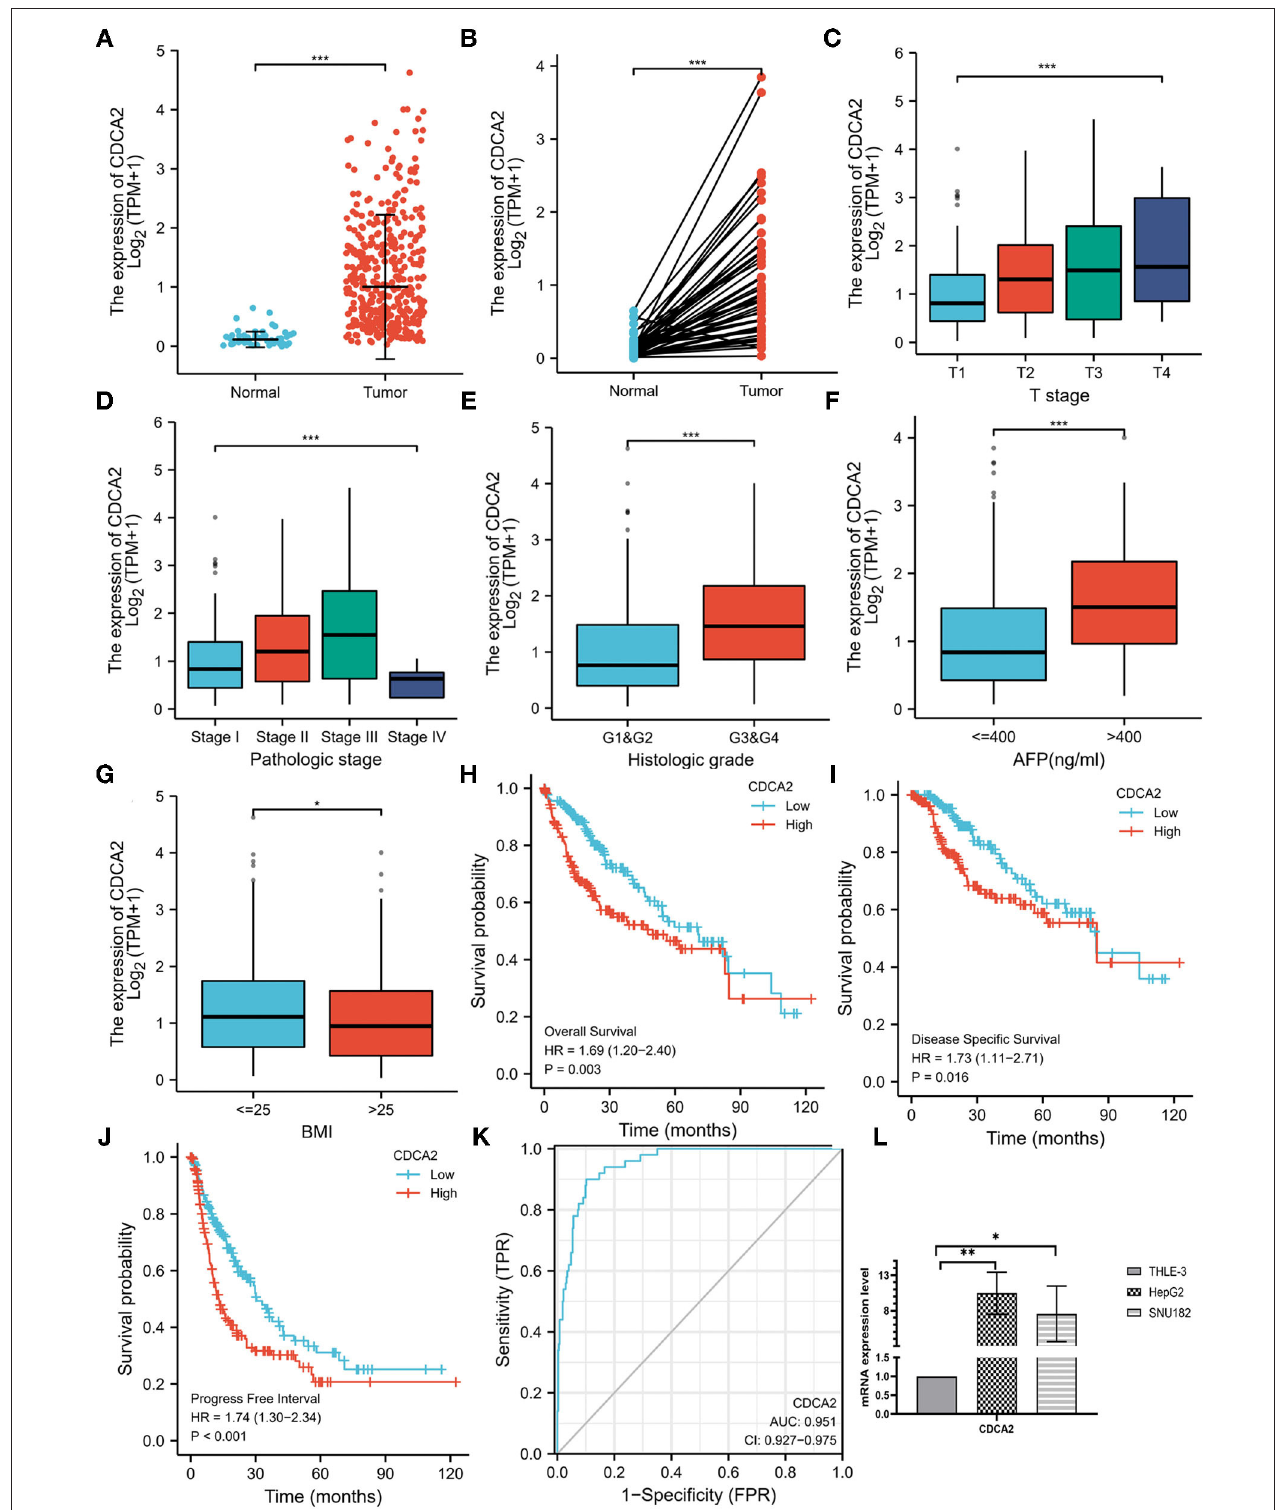
FIGURE 1 | Cell division cycle-associated protein 2 (CDCA2) expression in hepatocellular carcinoma (HCC) and the correlations between CDCA2 expression and clinicopathological characteristic. (A) Cell division cycle-associated protein 2 expression in HCC tissues and normal tissues (Wilcoxon rank sum test, *** p < 0.001). (B) Cell division cycle-associated protein 2 expression in HCC tissues and adjacent noncancerous tissues (Wilcoxon signed rank test, *** p < 0.001). (C) Expression